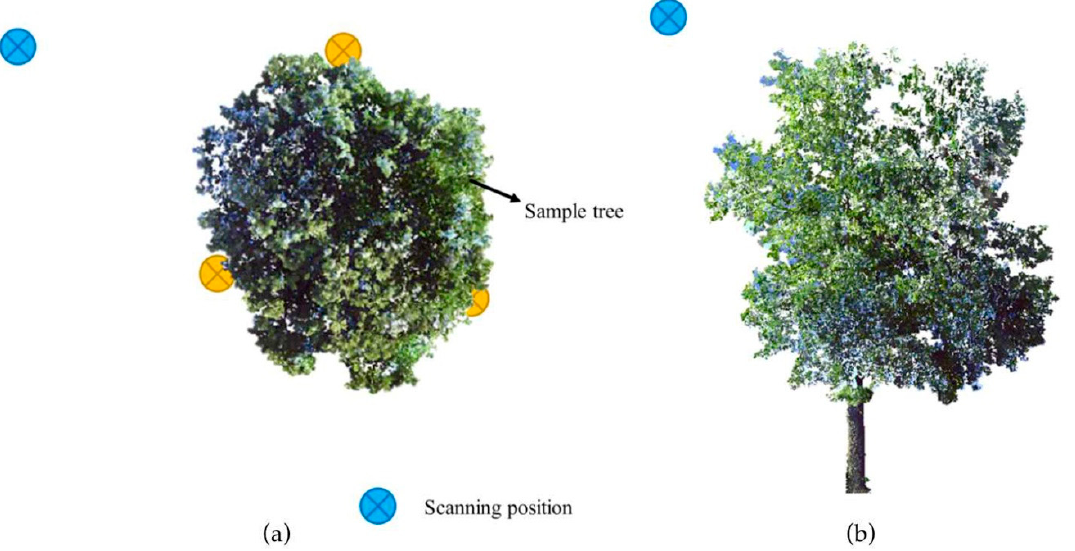
Figure 4. ( a ) Location of the laser scanner (view from above) relative to the stem position, blue circles represent the scanning positions far from the tree, yellow circlets represent the scanning positions close to the stem; and ( b ) extracted point cloud (view from the front). Sample Tree 21.